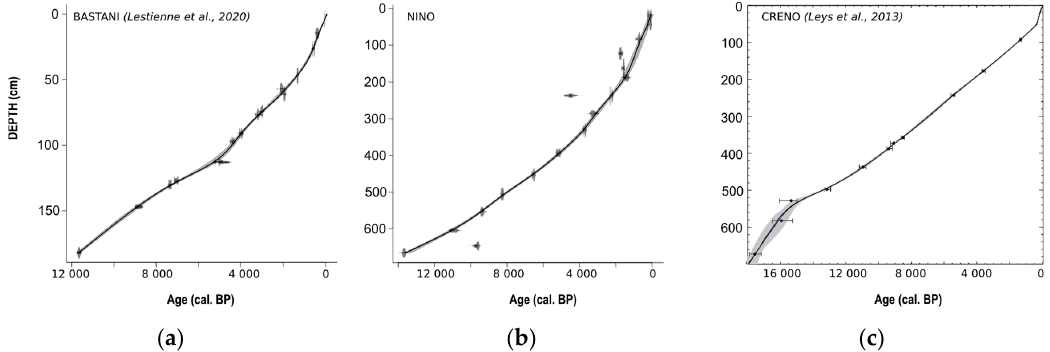
Figure A1. Age-depth model for Bastani [33], Nino, and Creno [42] sequences. The chronological control was based on a combination of ( a ) 10 (Bastani)/18 (Nino)/11 (Creno) radiocarbon dates obtained at the Poznan Radiocarbon Laboratory on diverse macro-remains of terrestrial origins (leaves, seeds, charcoals, and wood). ( b ) One age estimated for the main late-glacial/early-Holocene transitions indicated by the pollen stratigraphy and the geochemistry data (Bastani). ( c ) Two (Bastani)/seven (Creno) radiometric markers derived from short-lived radionuclides (210Pb, 137Cs) for the top of the core. Based on these chronological markers, the Clam package (R software, R. Core Team, 2018) was used to generate an age depth model within the 95% confidence limits [96].